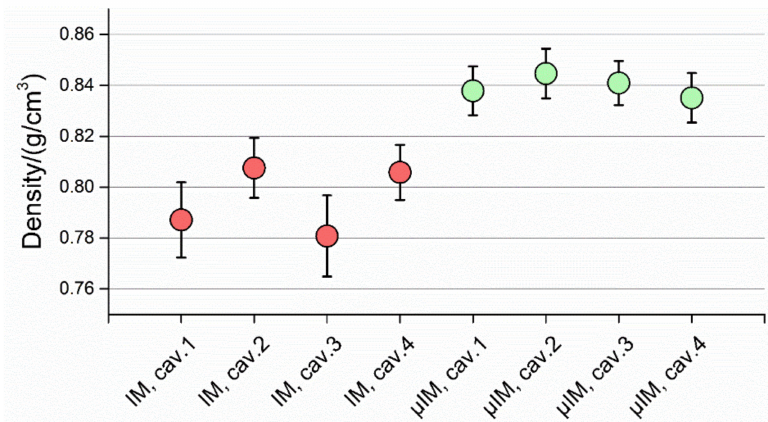
Figure 18. Density calculations for IM (light blue) and µ IM (red). The interval bars indicate the standard deviations of the 10 parts per cavity.